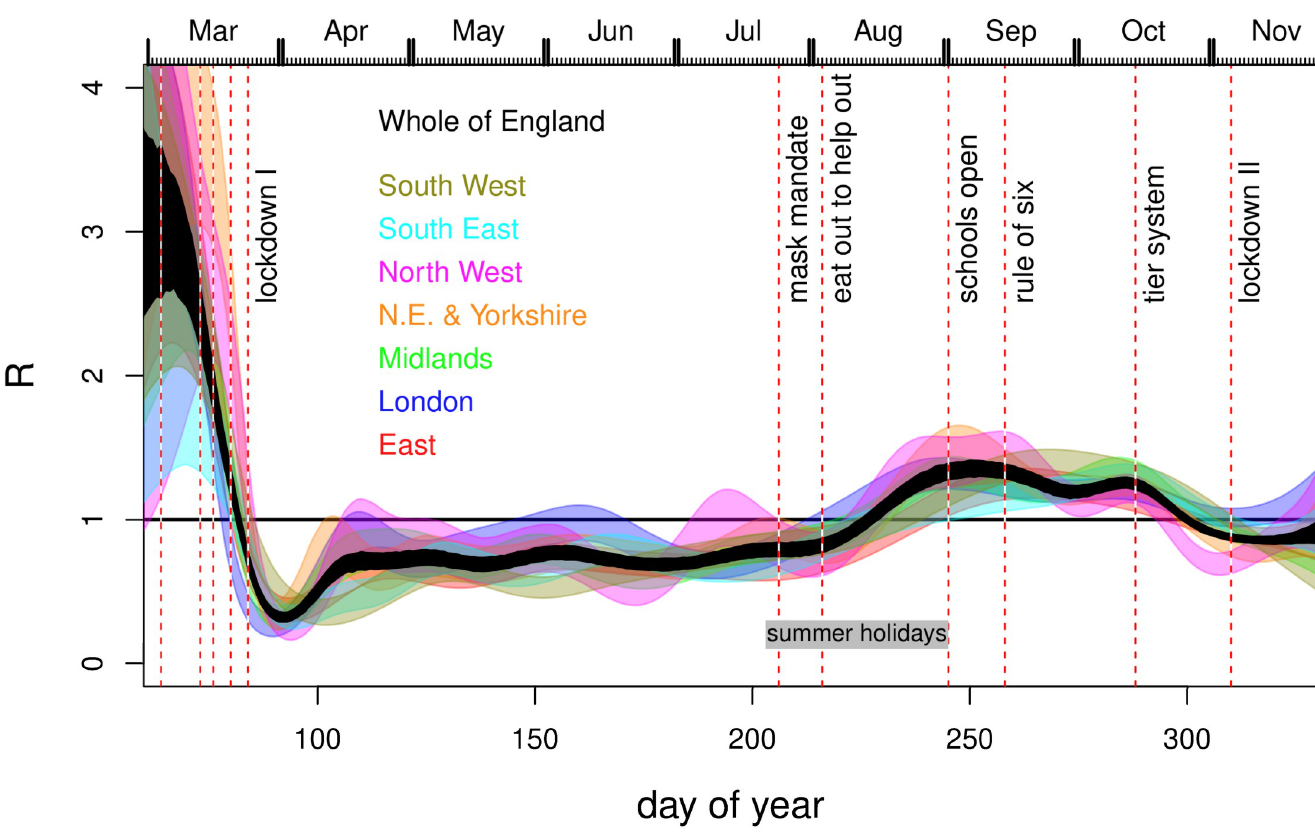
Fig 5. Inferred R for all regions (colour) and the infectives-weighted average for the whole of England (black). Notional 95% credible bands are shown. These do not reflect all the uncertainty in rate parameters and assume a correct model structure: hence they provide a lower bound on uncertainty. Vertical dashed lines as Fig 4.